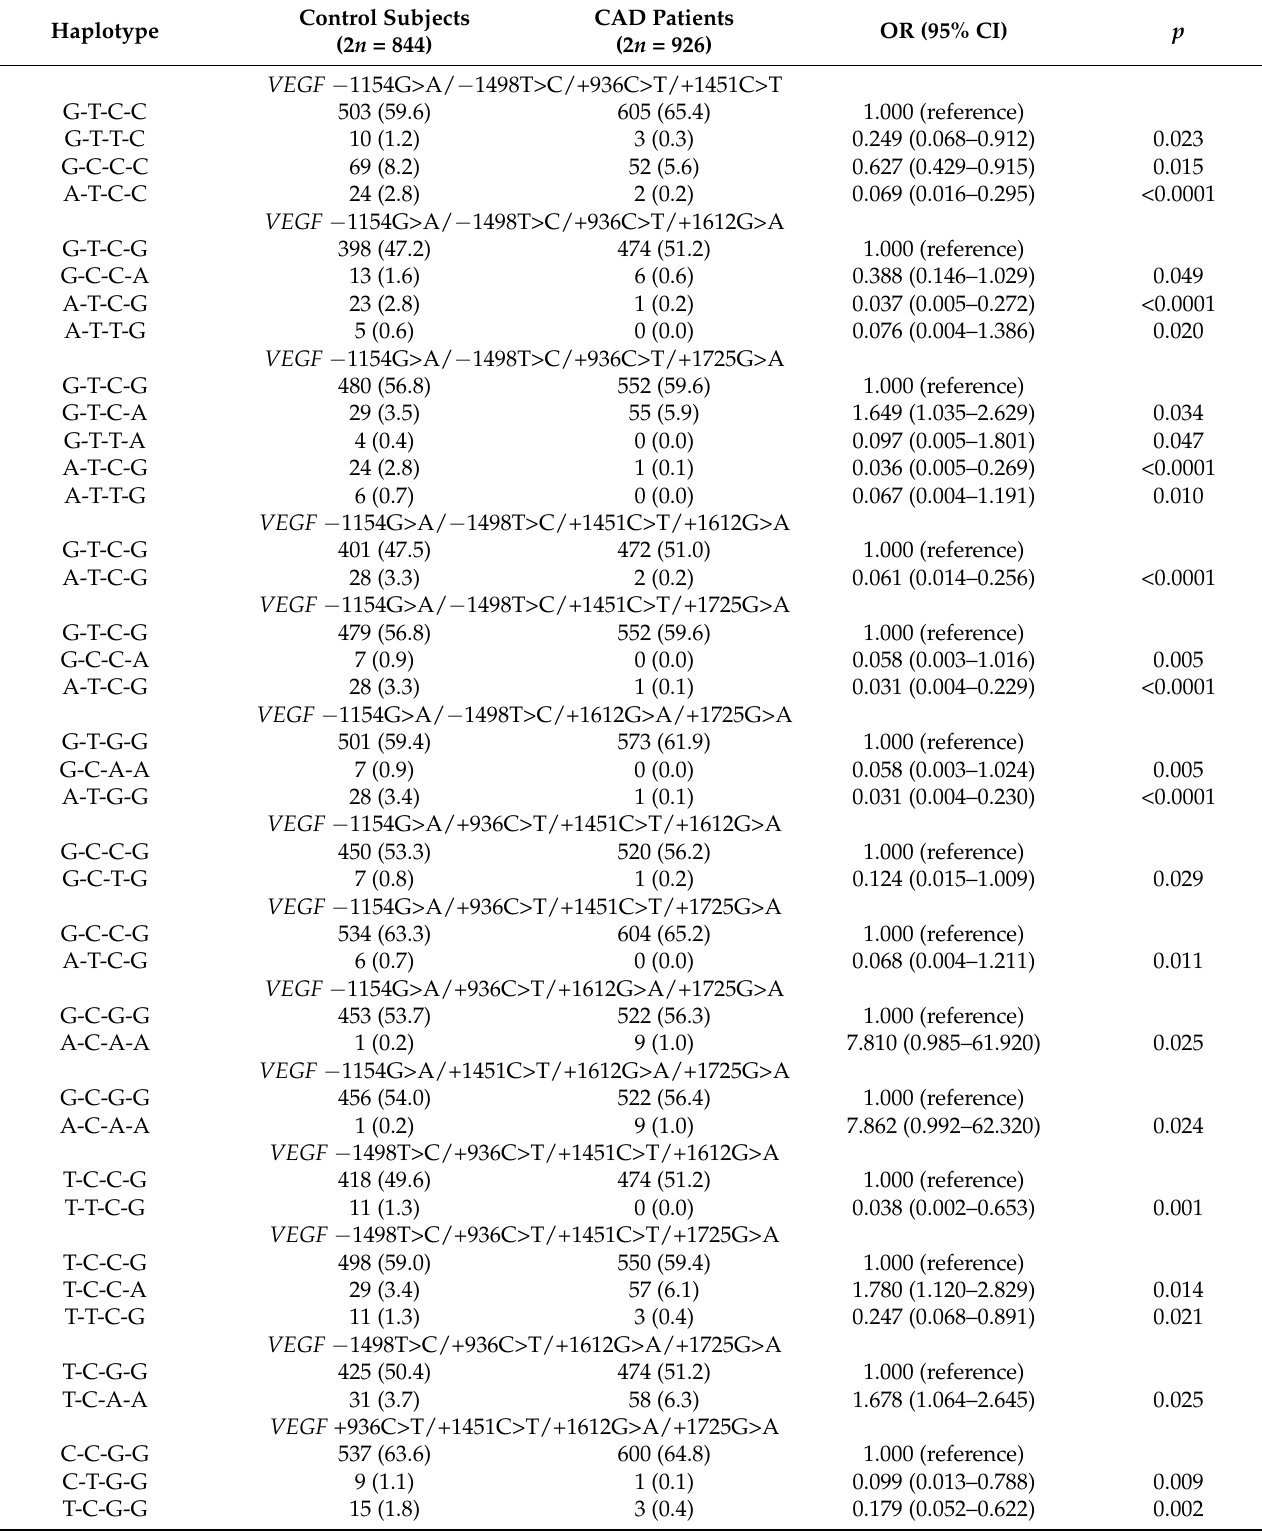
Table 5. Haplotype analysis of VEGF polymorphisms in CAD patients and controls